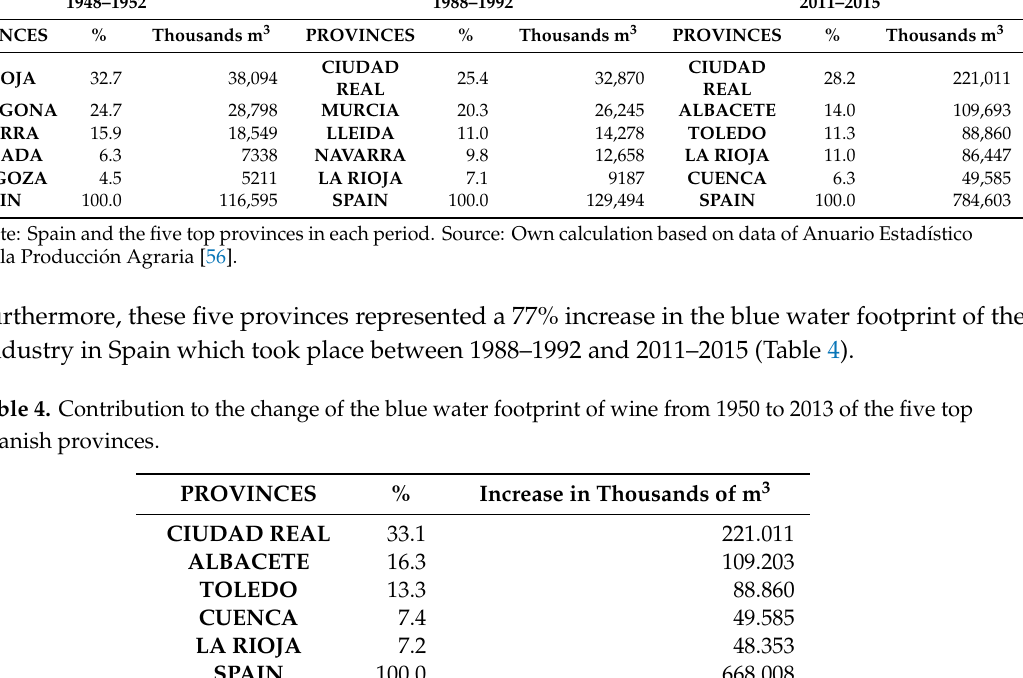
Table 3. Average provincial share in the blue water footprint of wine in Spain.